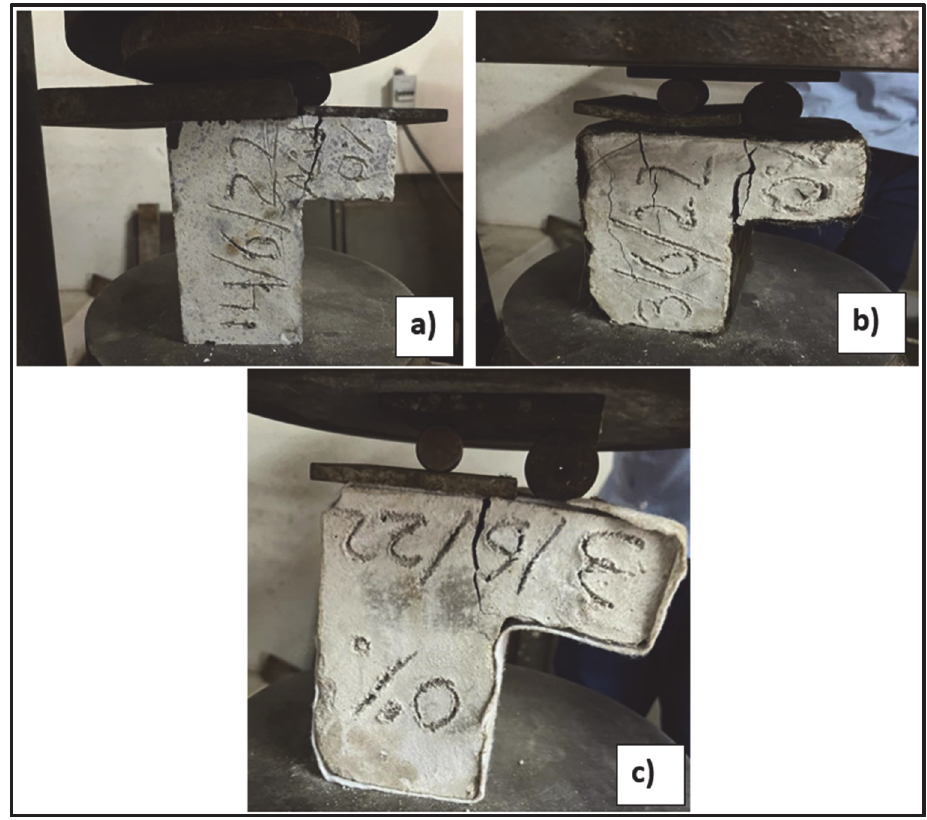
Figure 8: Cracked concrete samples under Shear Test (a) Plain Concrete (b) BFM wrapped and (c) GFM wrapped samples. Impact